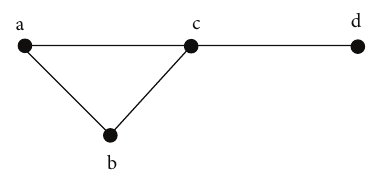
Figure 1: 3-cycle 𝐺 : with one additional vertex and edge.